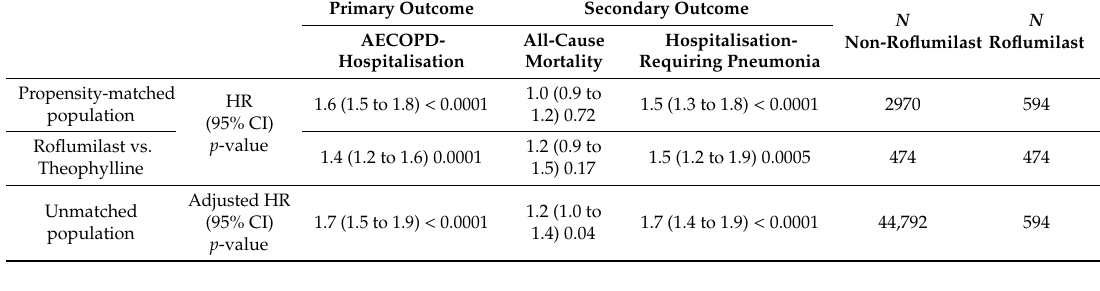
Table 2. Risk of hospitalization-requiring acute exacerbations after initiation of roflumilast therapy. Primary Outcome Secondary Outcome